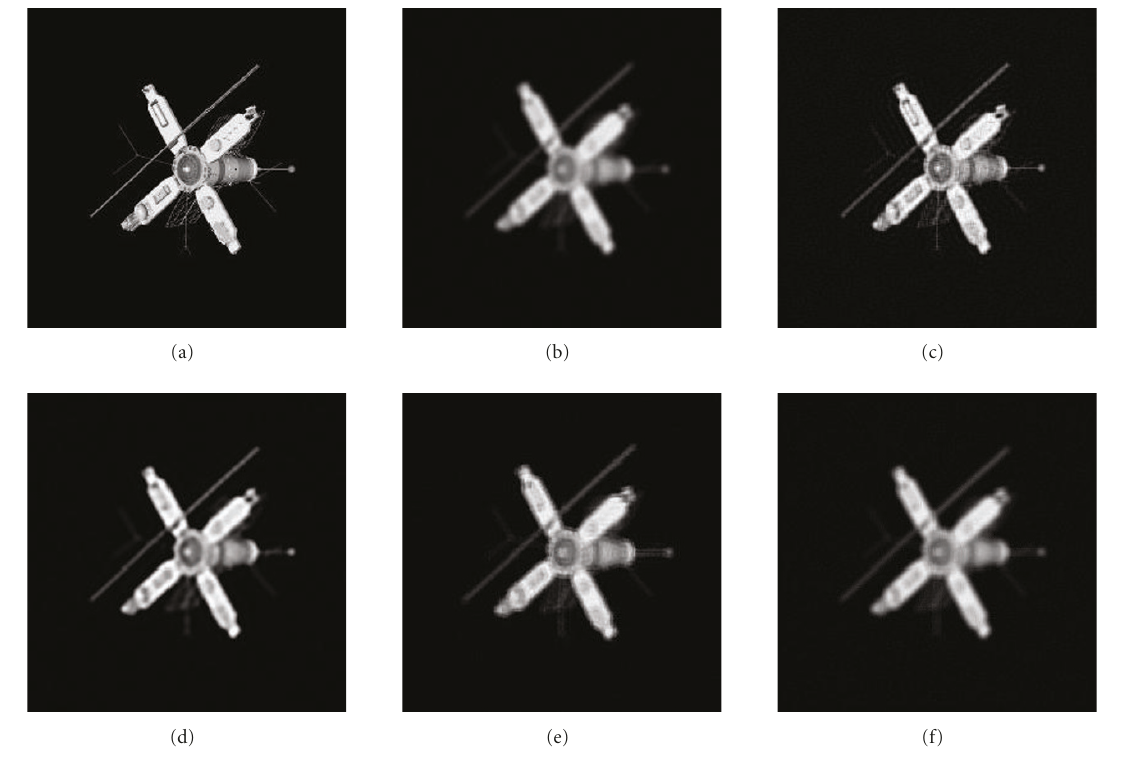
Figure 3: Comparison of di ff erent restoration results in 30 dB noise environment. (a) Original “satellite” image. (b) One of the three de- graded images. (c) Restored image using the proposed MRF algorithm. (d) Restored image using the CGO-AM algorithm. (e) Restored image using the TV-AM algorithm. (f) Restored image using the WF-AM